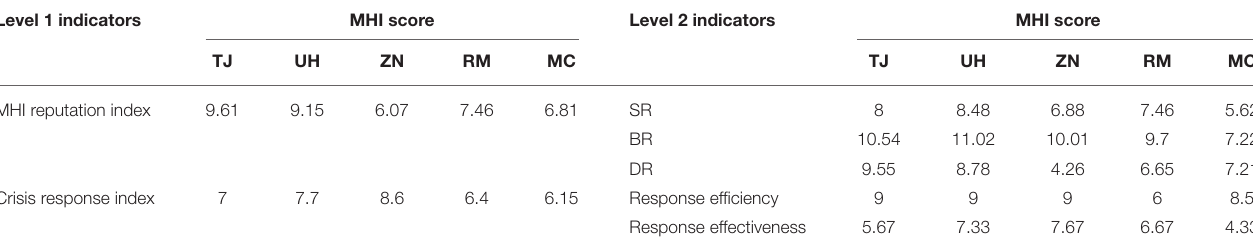
TABLE 1 | Score of each index of MHI reputation crisis management.